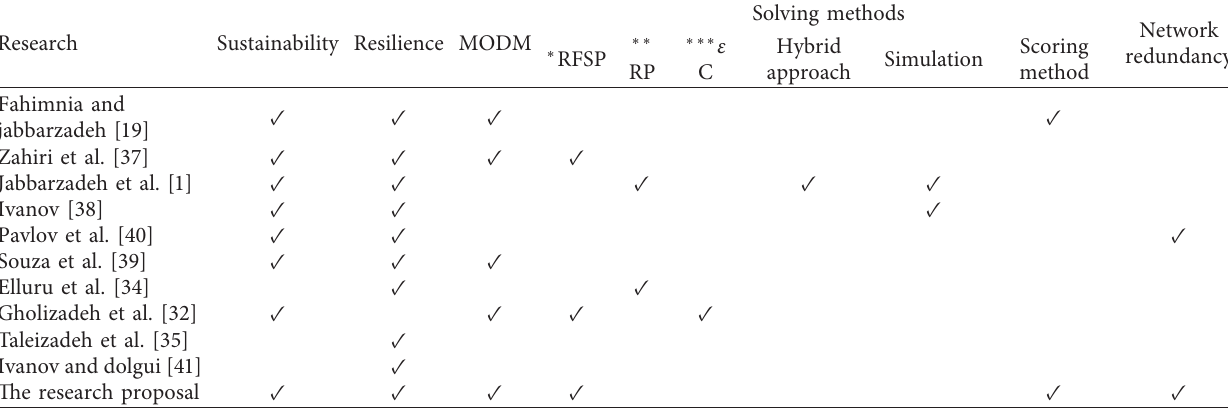
Table 1: Literature review of sustainability and resilience in supply chain network